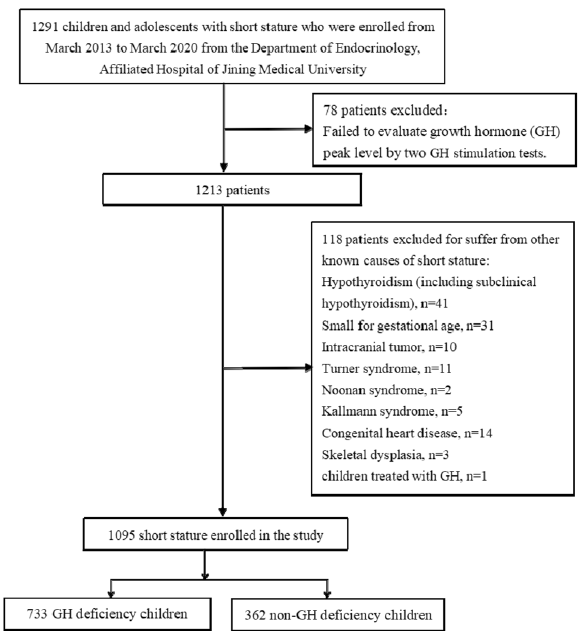
Figure 2. Flow chart of the study